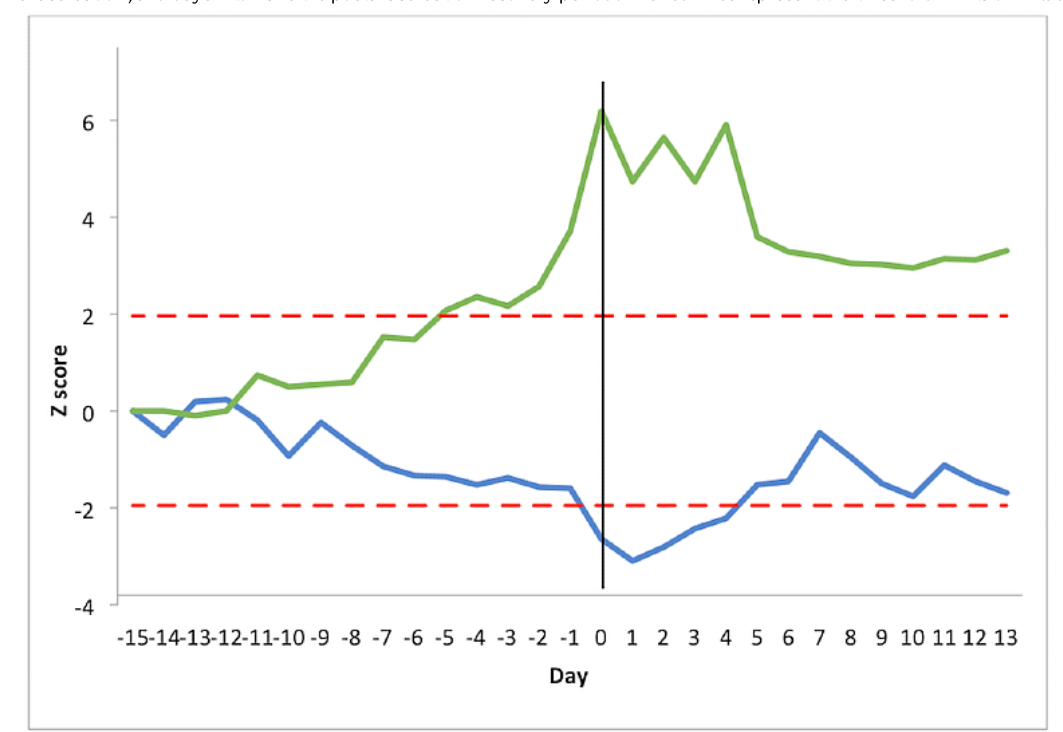
Figure 2. Chronic obstructive pulmonary disease assessment test score (green line) and peak expiratory flow (blue line) changes pre and post exacerbation in 27 patients with chronic obstructive pulmonary disease. The y-axis represents Z score relative to the patient’s baseline mean. The x-axis represents the time expressed in days. Day −15 is the mean of the stable period, days −14 to −1 is the preexacerbation period, day 0 is the day of initiation of treatment for exacerbation, and days 1 to 13 is the postexacerbation recovery period. The red lines represent the threshold limits of ±1.96